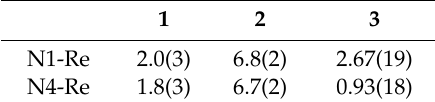
Table 2. Angle between pyridine ring and N-Re bond [ ◦ ].